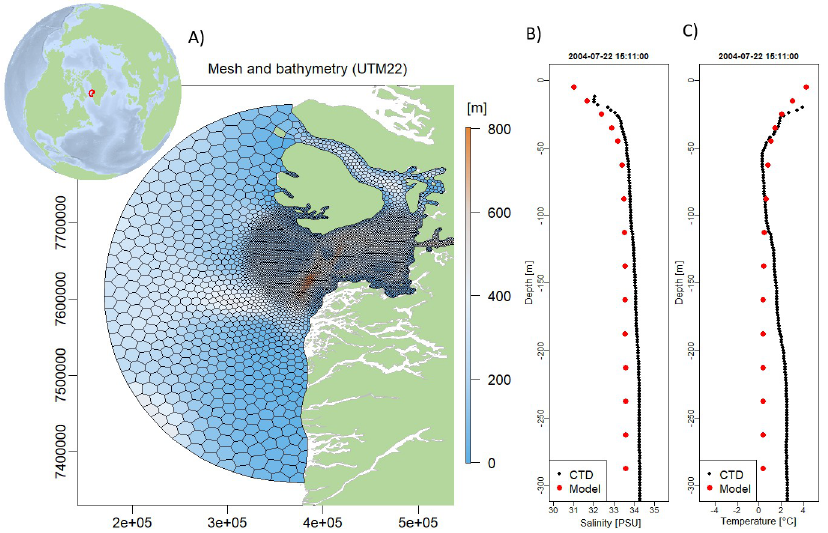
Fig 3. Disko Bay in Western Greenland. A) Location and computational mesh and B-C) Comparison of model and CTD measurements from 22 July